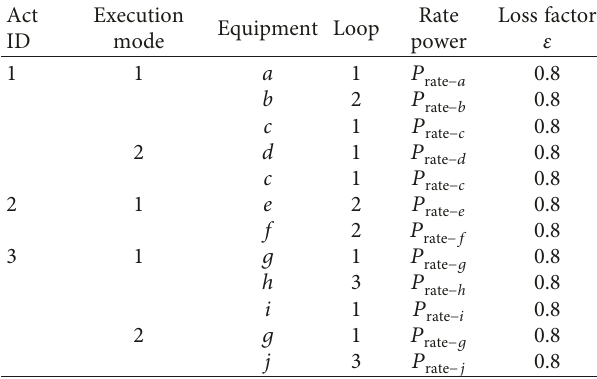
Table 2: Example of on-site power load constraint.